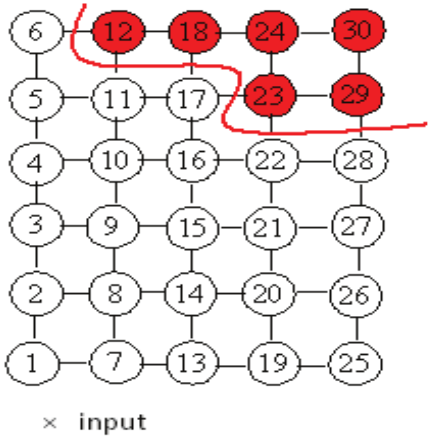
Fig. 1.Two groups of neurons on the map (6×5) are separated by red line: The distant neurons are {12,18,23,24,29,30} colored red. Rest neurons are normal neurons. × indicates the input